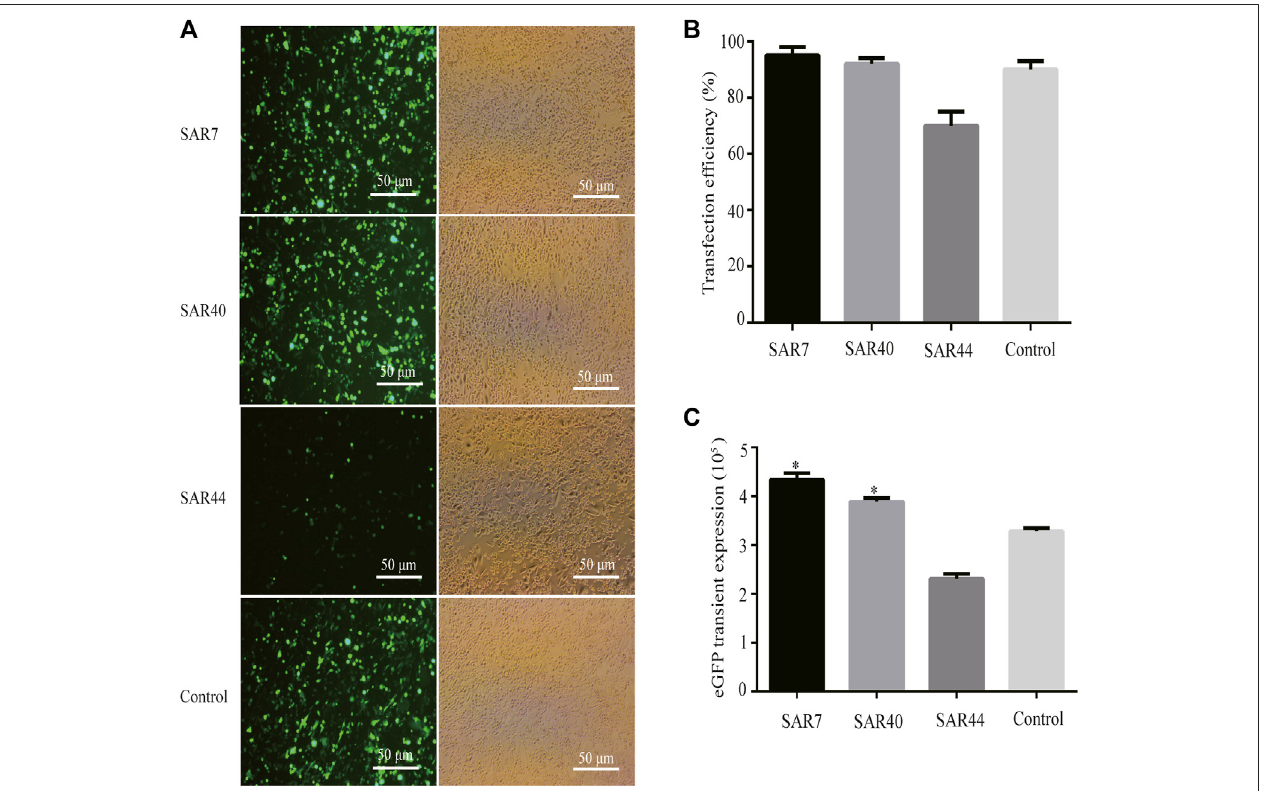
FIGURE 2 | Transient expression of recombinant protein in transfected pools of different SARs. Three vectors were transfected into CHO cells, 48 h after transfection,andthetransfectionef fi ciencieswereestimated. (A) Therepresentative photoswereobservedby fl uorescence microscopy. (B) Analysisofthetransfection ef fi ciency. (C) Analysis of the eGFP transient expression. The results are the mean values obtained for three independent experiments, and the standard deviation is indicated (* p < 0.05).